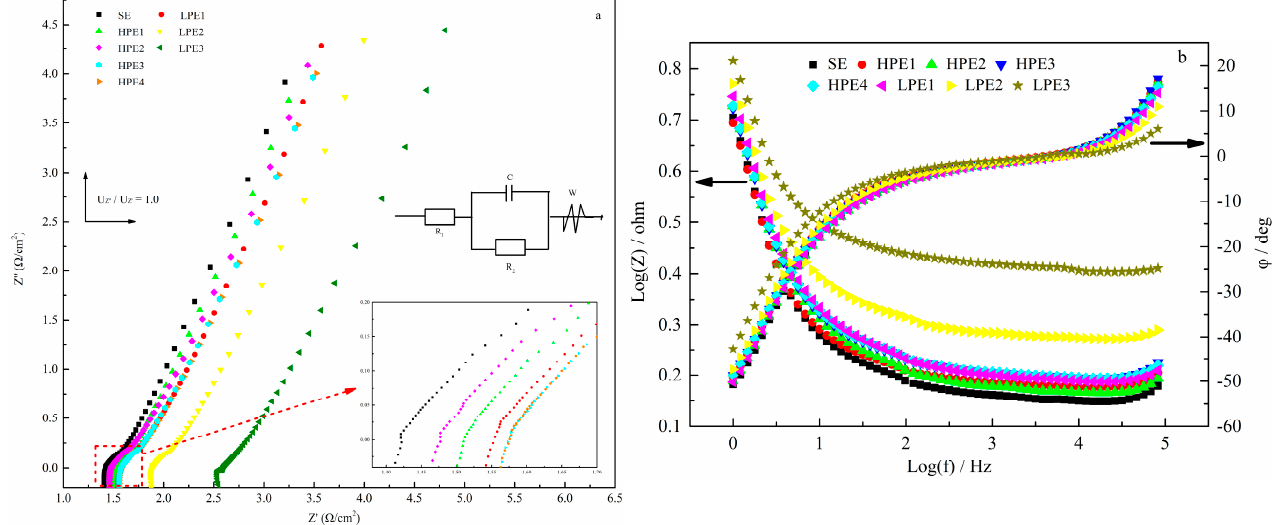
Figure 5. The EIS curves and the equivalent electric circuit model of V(IV) electrolytes prepared with different grades of V 2 O 5 raw materials; ( a ) Nyquist plots, ( b ) Bode plots. Table 3. The parameters resulting from fitting the EIS tests with the equivalent electric circuit model.